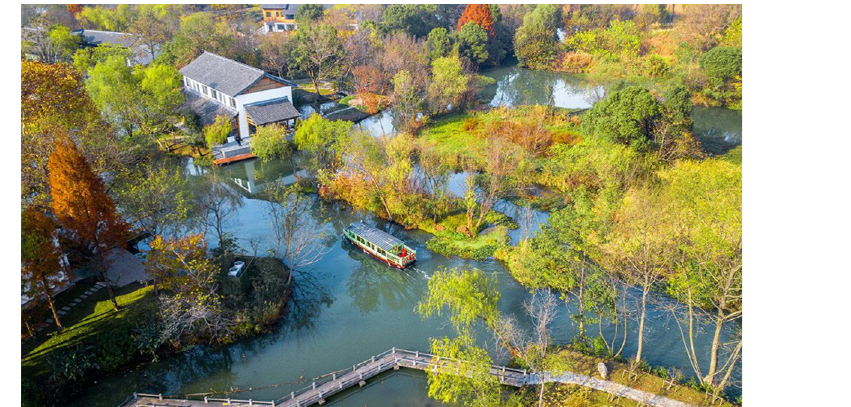
Fig 3. Survey region of Xixi National Wetland